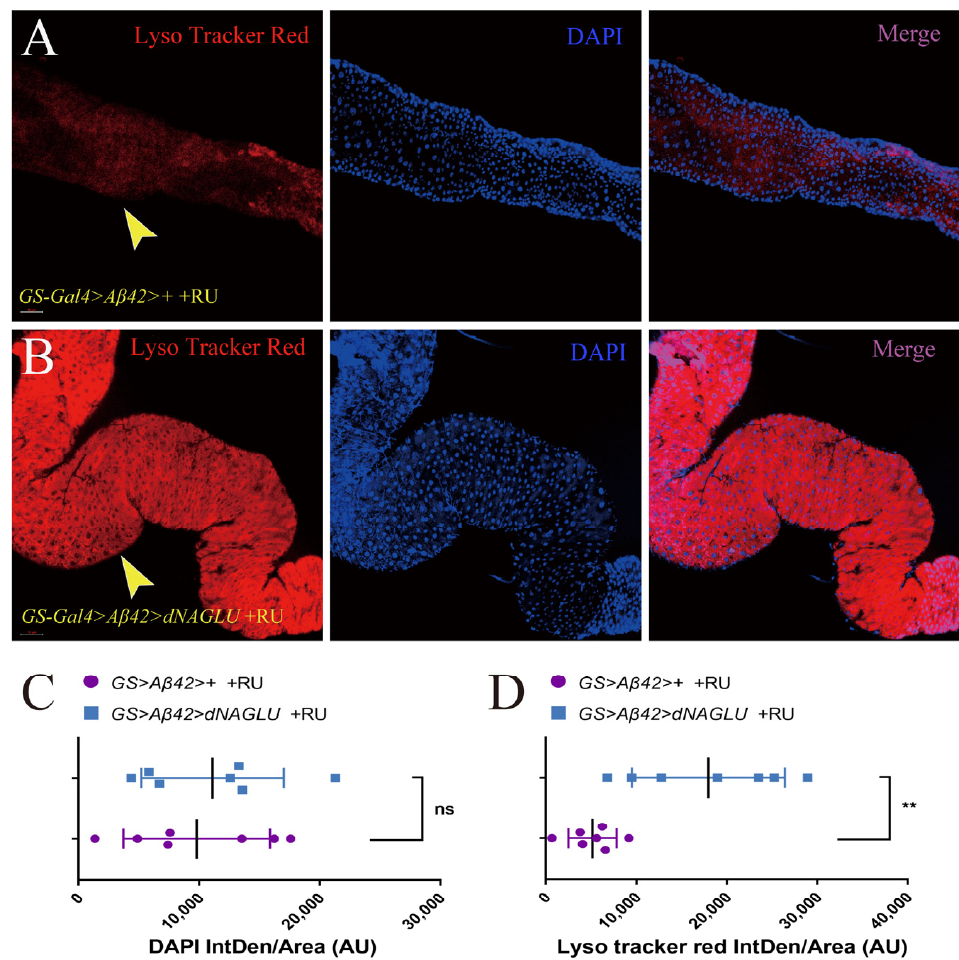
Figure 5. Overexpression of dNAGLU in AD Drosophila enhances intestinal lysosomal activity: ( A , B ) Immunofluorescence using Lyso Tracker Red in Drosophila guts. ( A ) GS-Gal4>A β 42> + +RU flies; ( B ) GS-Gal4>A β 42>dNAGLU +RU flies; ( C ) the integrated density of Lyso Tracker Red/area are shown as bar plots ( n = 7, p = 0.0024, t -test); ( D ) the integrated density of DAPI/area are shown as bar plots ( n = 7, p = 0.6908, t -test). The nuclei are stained with DAPI in blue. ** p < 0.01, ns represents non-significant.